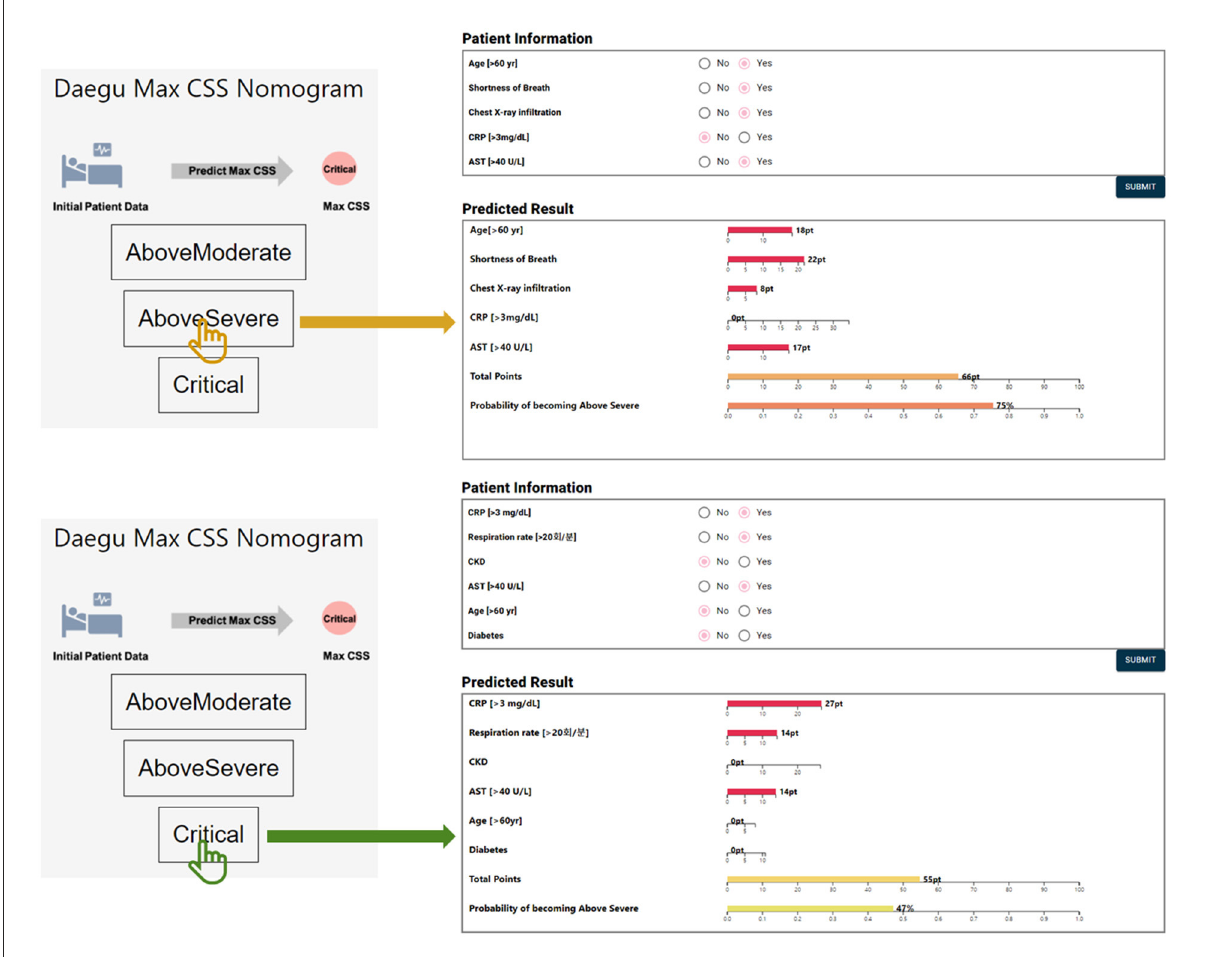
FIGURE3 An example of the nomogram for each